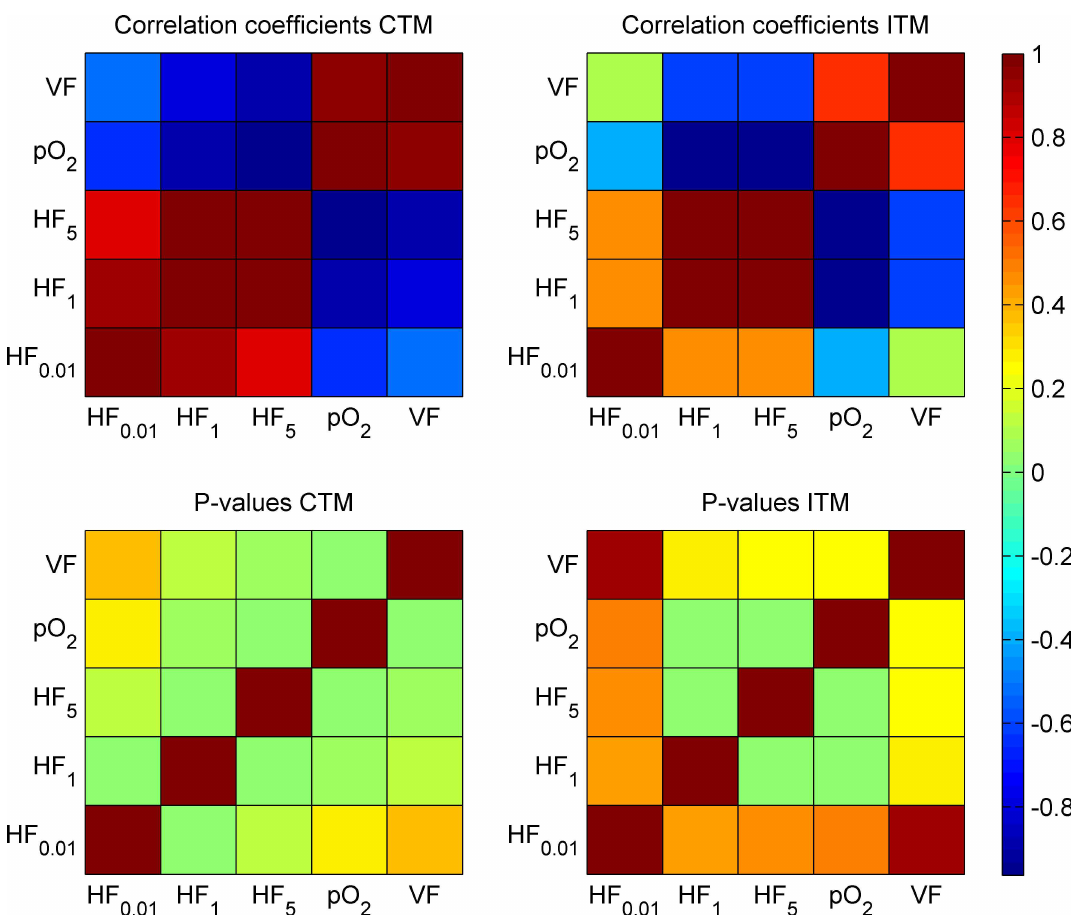
Fig 8. Correlation and significance. Correlationcoefficientsand p-valuesfor the propertiesof the five samples. The correlationcoefficients (upper panels) show the sign and strength of the correlations, while the p-value(lower panels) may be used to evaluatethe significance. The lower left to upper right diagonals of all panels, by necessity, contain nonsense